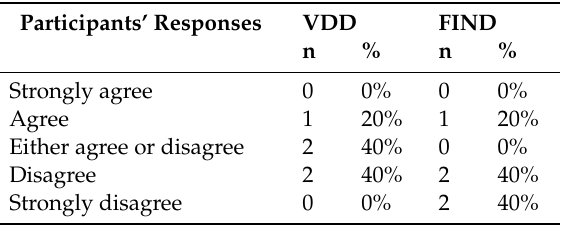
Table 14. Participants’ confidence level using spatial metadata in the